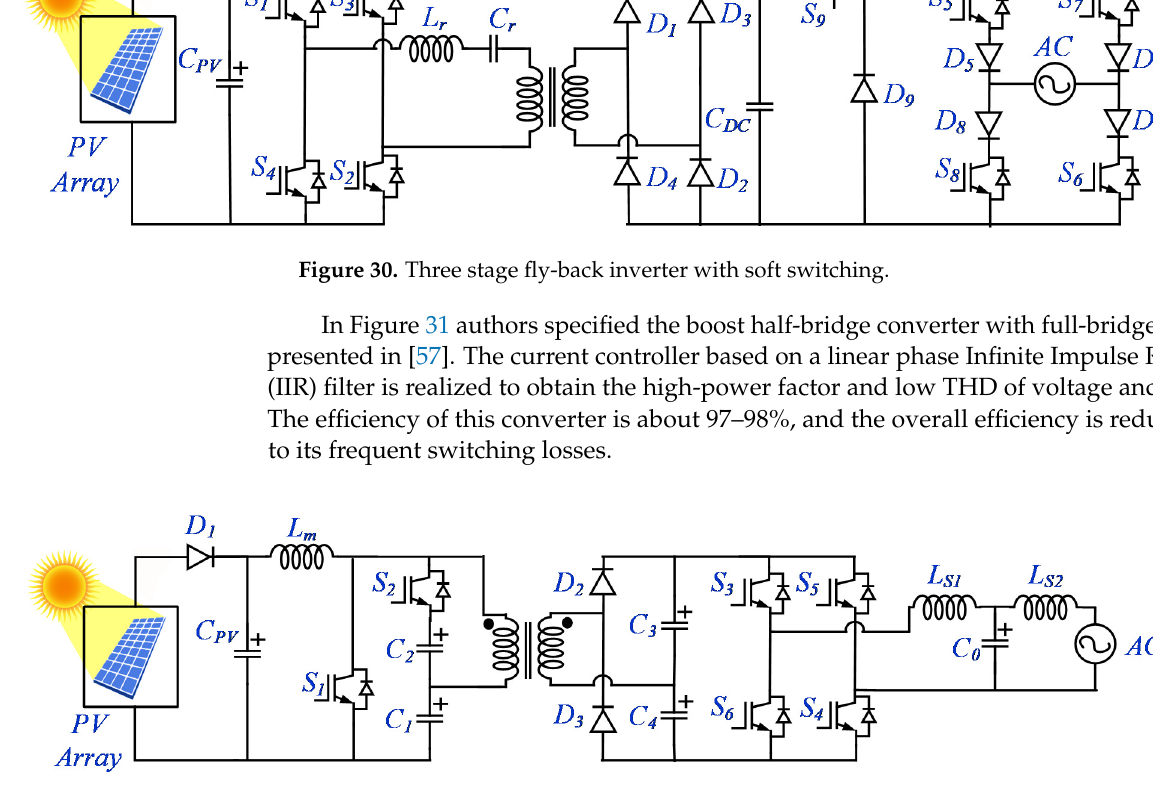
Figure 31. Boost half-bridge converter with full bridge inverter.